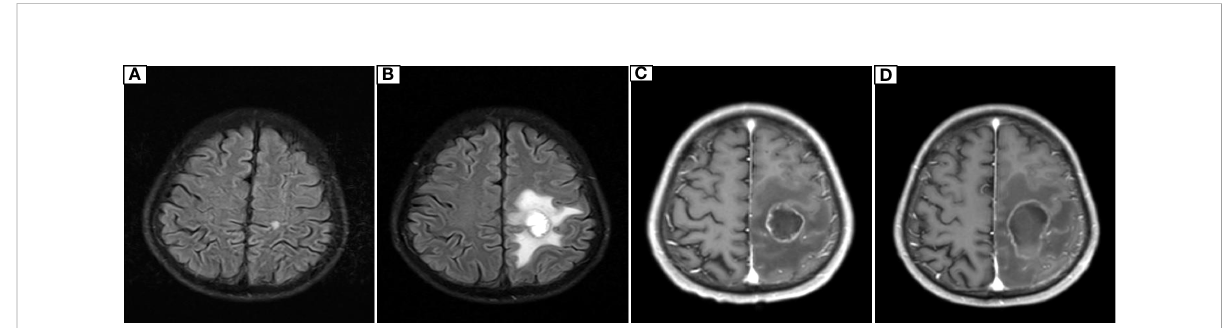
FIGURE 6 Dynamic changes on cranial MR. (A) The initial cranial MR on January 28, 2019, showed a nodular lesion in the left parietal lobe with a diameter of approximately 0.6 cm and a clear margin. (B) On December 6, 2019, cranial MR showed that the left parietal lobe nodule was enlarged to 2.1 cm × 2.3 cm, with blurred edges and patchy surrounding edema. (C) On March 23, 2020, cranial MR showed that the left parietal lobe nodule had grown to 3.0 cm × 2.3 cm and had blurred edges and visible patchy edematous lesions around it. (D) Cranial MR showed that the left parietal nodular lesion had grown to 4.5 cm×2.5 cm, with blurred edges and patchy edematous lesions.